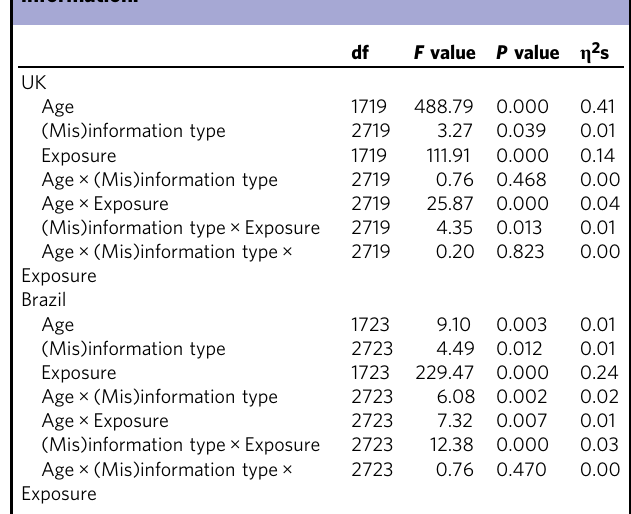
Table 3 Main and interaction effects of age, (mis) information type, and exposure on intention-to-share information.